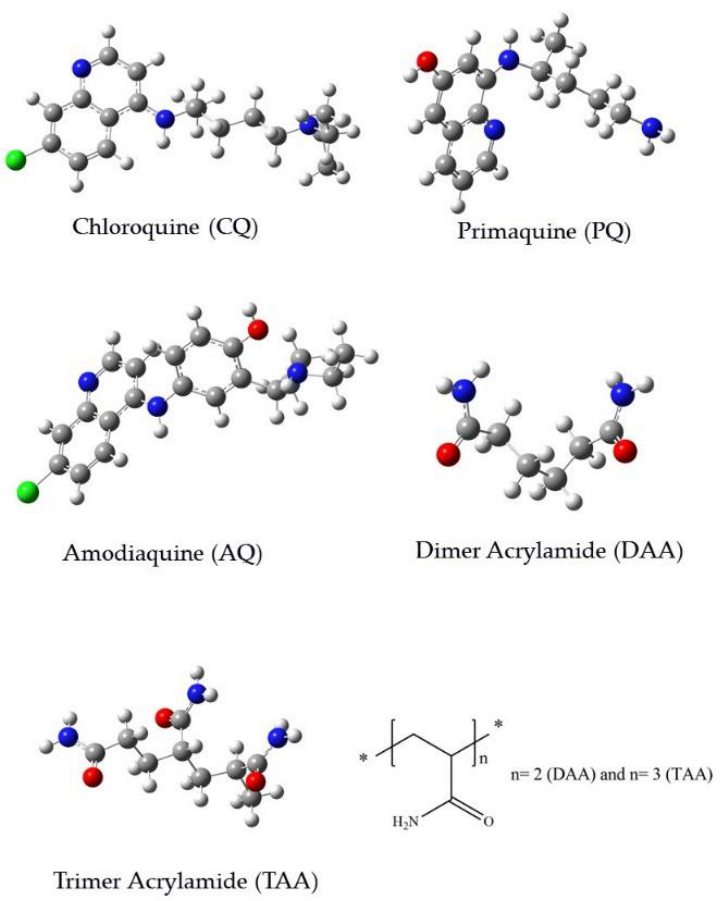
Figure 1. Geometrical structure for the minimum found at the wb97xd/6-31++G(d,p) level of theory for antimalarial compounds as well as the acrylamide dimer and trimer used as model of the polymer.